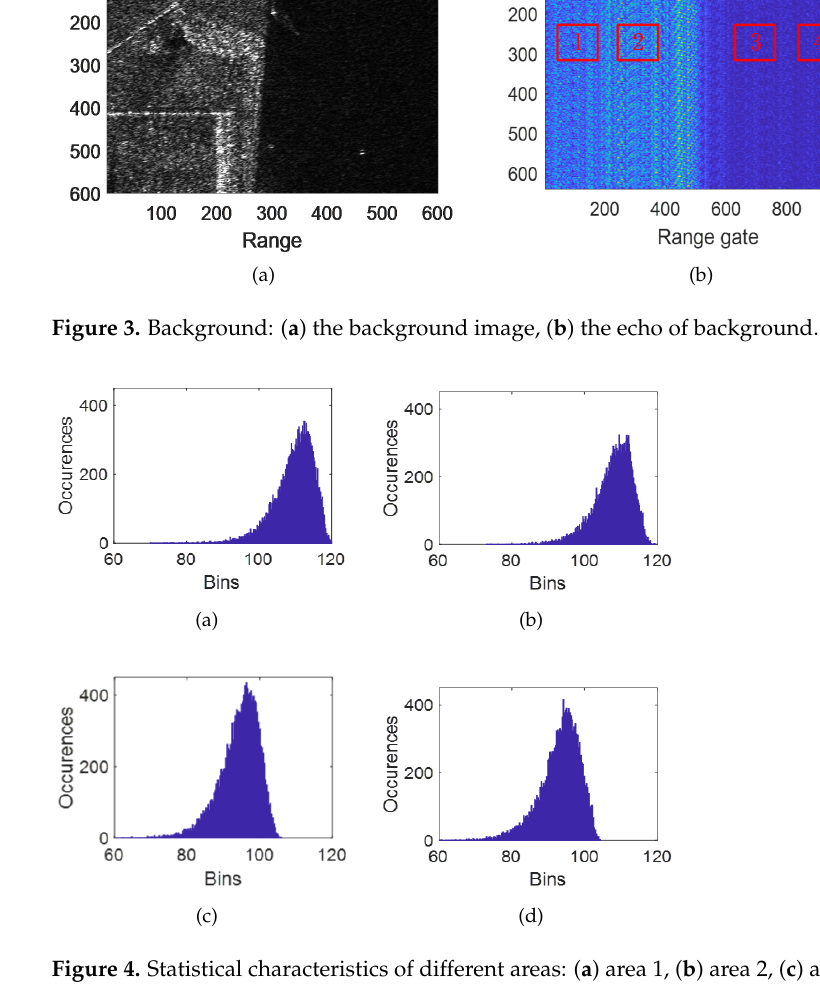
Figure 4. Statistical characteristics of different areas: ( a ) area 1, ( b ) area 2, ( c ) area 3, ( d ) area